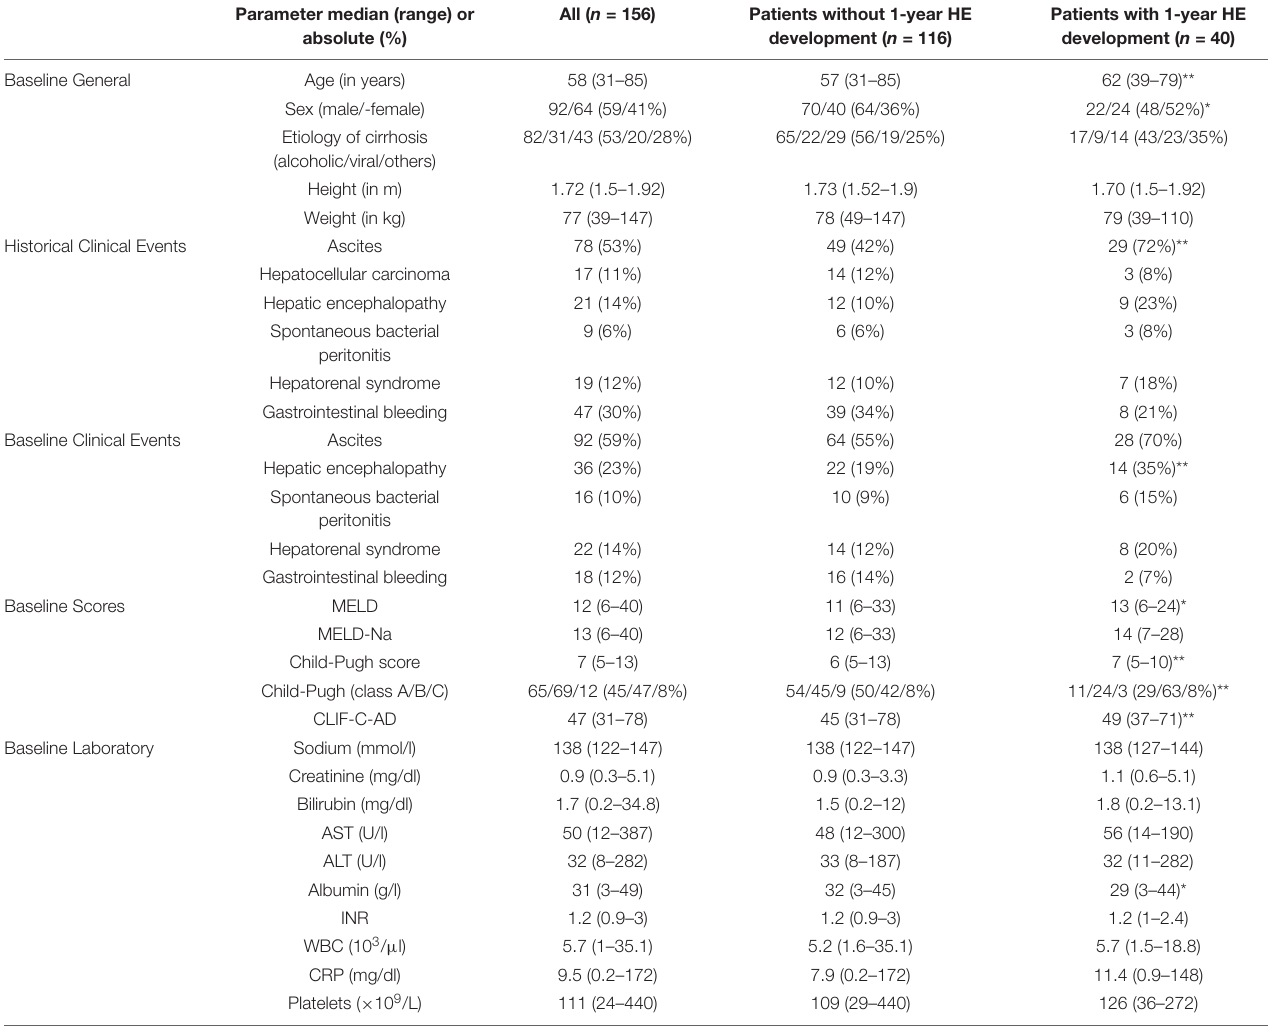
TABLE 1 | General characteristics stratified for 1-year hepatic encephalopathy (HE) development. Parameter median (range) or All ( n = 156) Patients without 1-year HE Patients with 1-year HE absolute (%) development ( n = 116) development ( n =